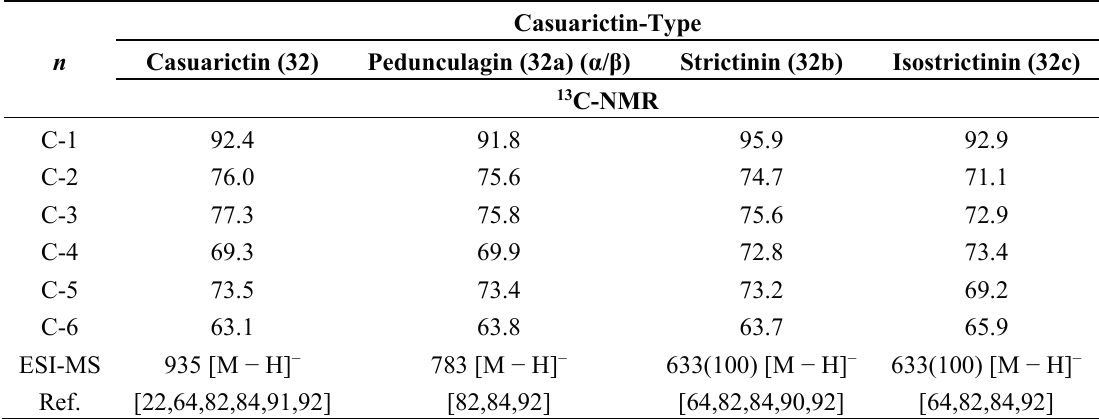
Table 4. 13 C-NMR and MS data of sugar moieties of casuarictin-type monomeric